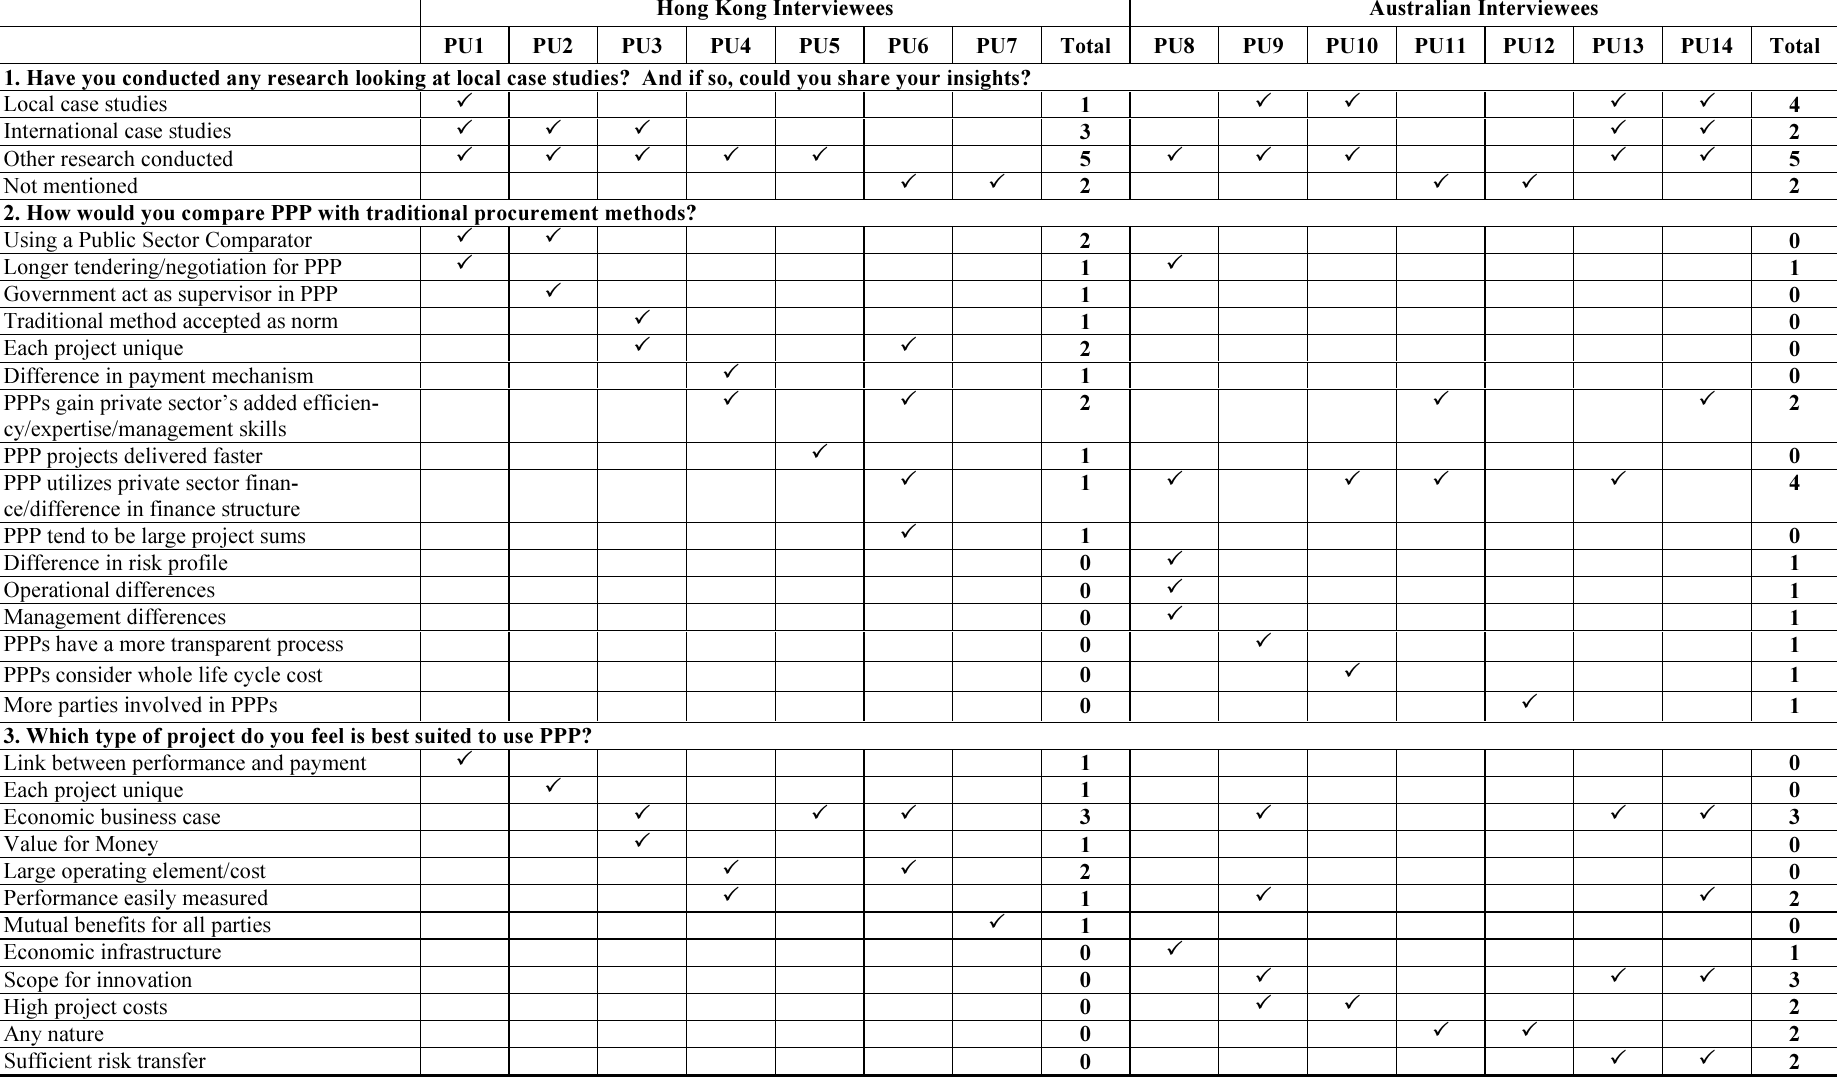
Table 5. Summary of responses from interviewees